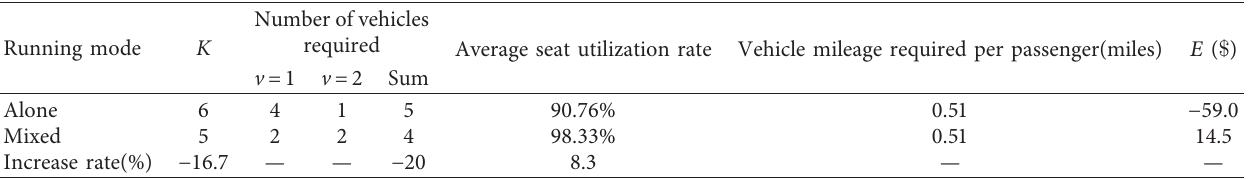
Table 9: Comparisons of two running modes in the initial service